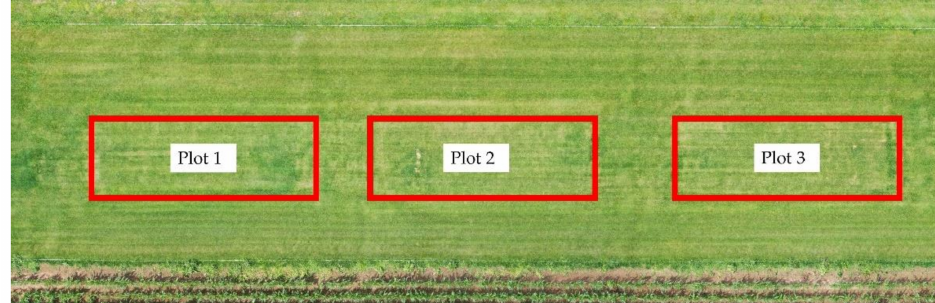
Figure 2. Aerial picture of the three plots used for the trials.